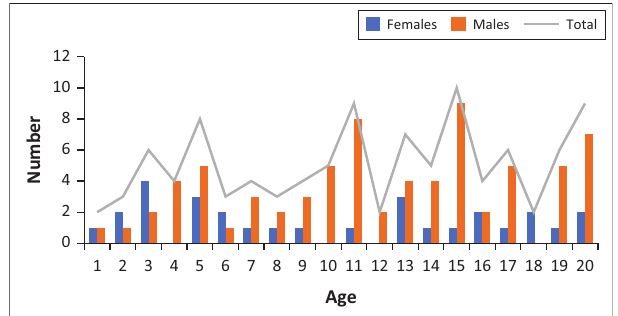
FIGURE 3: Age and sex distribution of the study population.